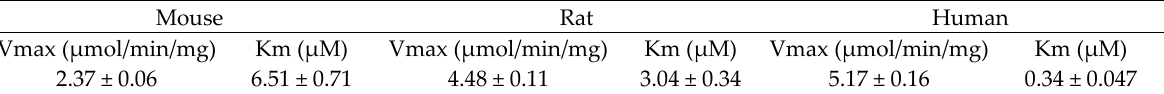
Figure 7. pNPG ( A , * p < 0.05, One-Way ANOVA) and wogonoside ( B , mouse; C , rat; D , Human) hydrolysis using enzymes from different species. ( B – D ) were Michaelis–Menten plots and ( E – G ) were Lineweaver–Burk plots. Wogonosides were incubated with the enzymes in buffers for 30 min at 37 °C (n = 3). The results showed that human fecal S9 is more active than that of rodents.